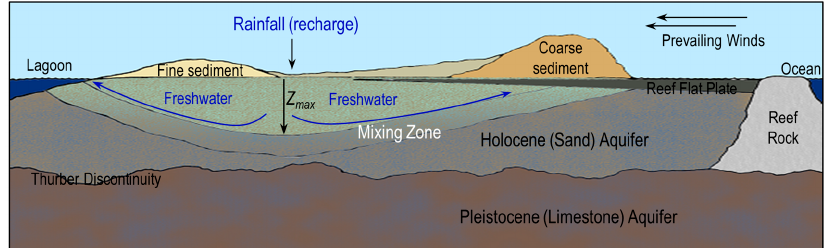
Figure 3. Geologic cross section of a typical atoll island from the lagoon side to the ocean side [16,24]. The lens thickness at the center of the island ( Z max ), the primary output from the algebraic model, also is shown in the figure.